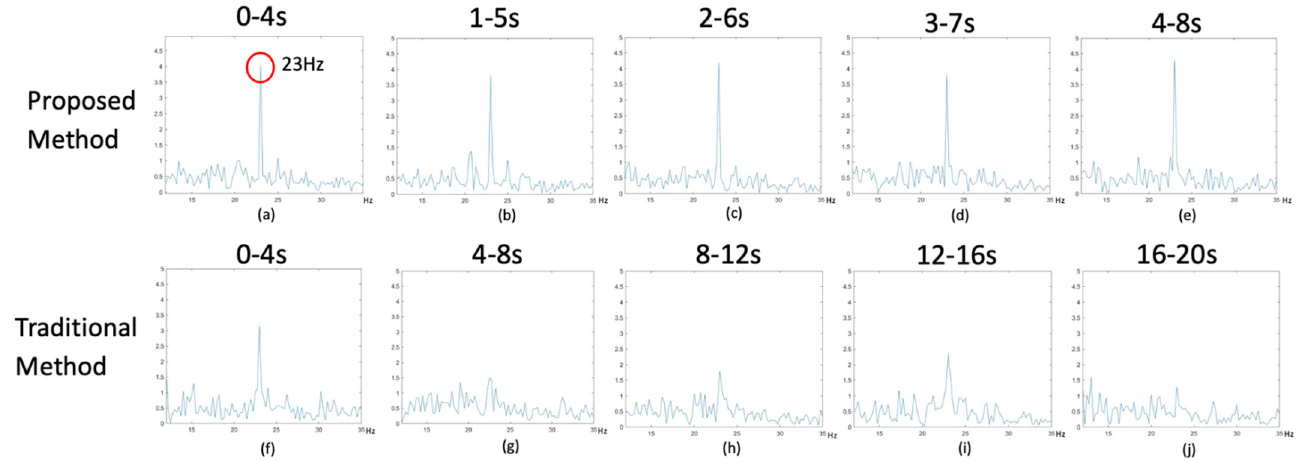
Figure 4. Comparison of the proposed method with the traditional method in 23 Hz brainwave signals.